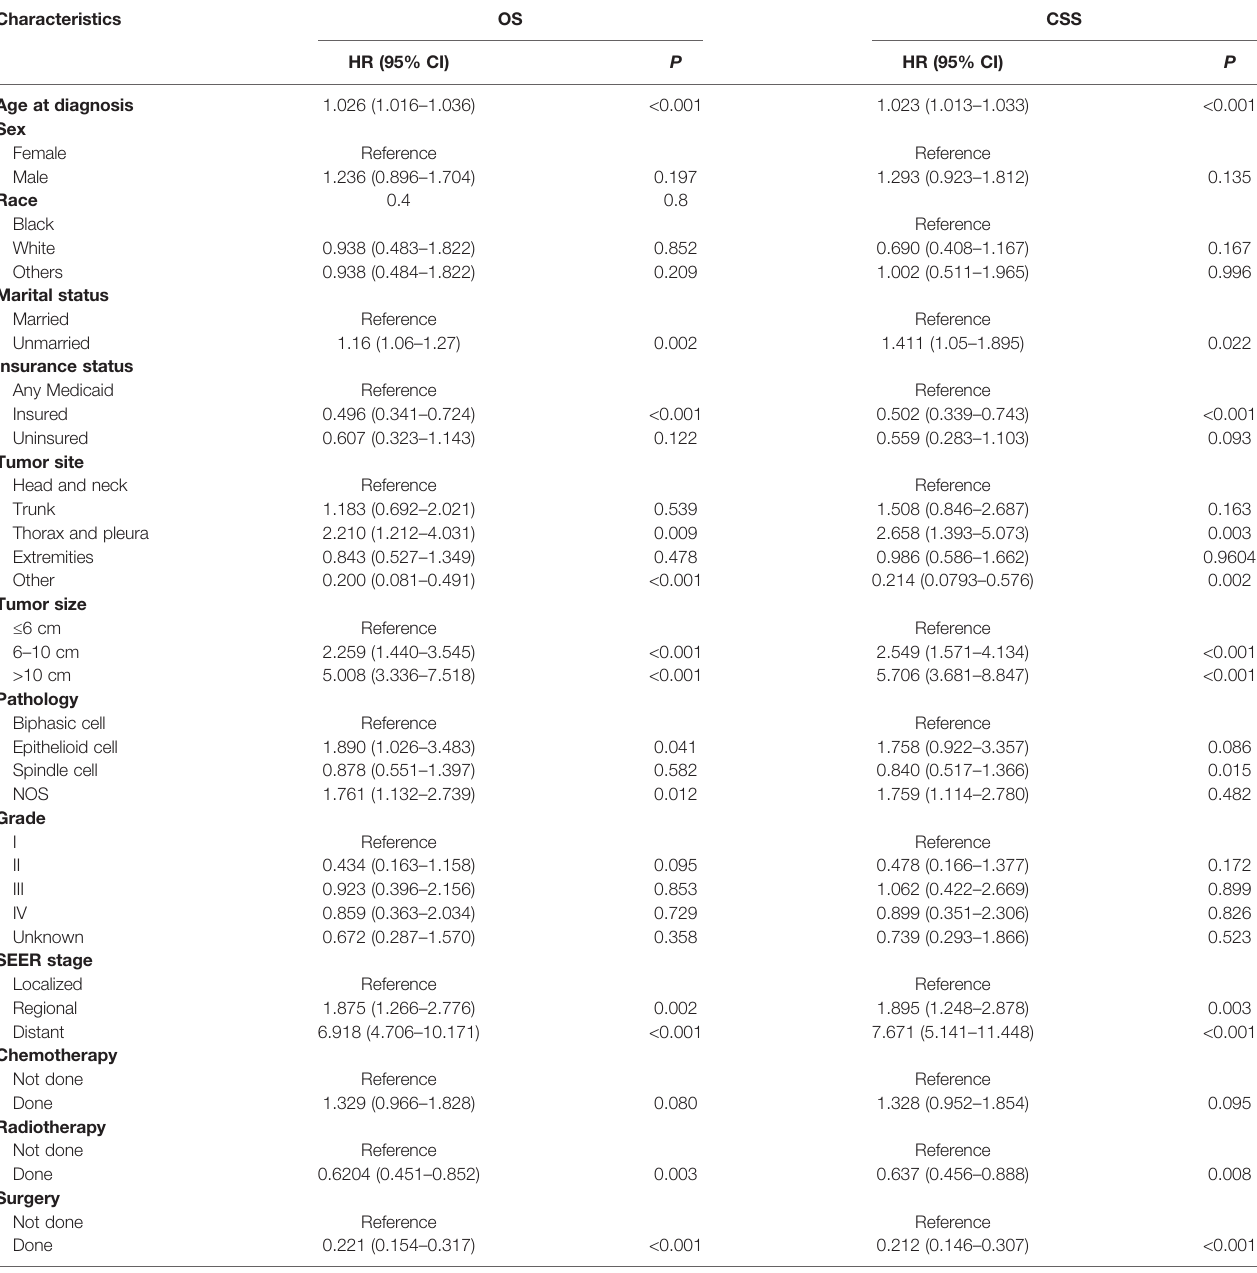
TABLE 2 | Univariate Cox regression analysis for OS and CSS of the SyS patients in the training cohort.